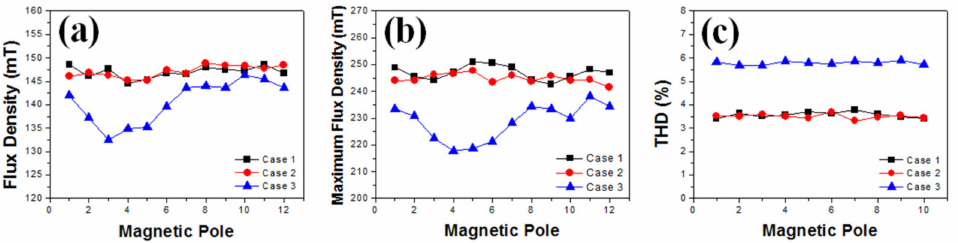
Figure 8. Magnetic property and total harmonic distortion analysis results obtained with Nd 2 Fe 14 B magnets using a magnetized yoke in cases 1~3 (( a ) flux density; ( b ) maximum flux; and ( c ) THD).